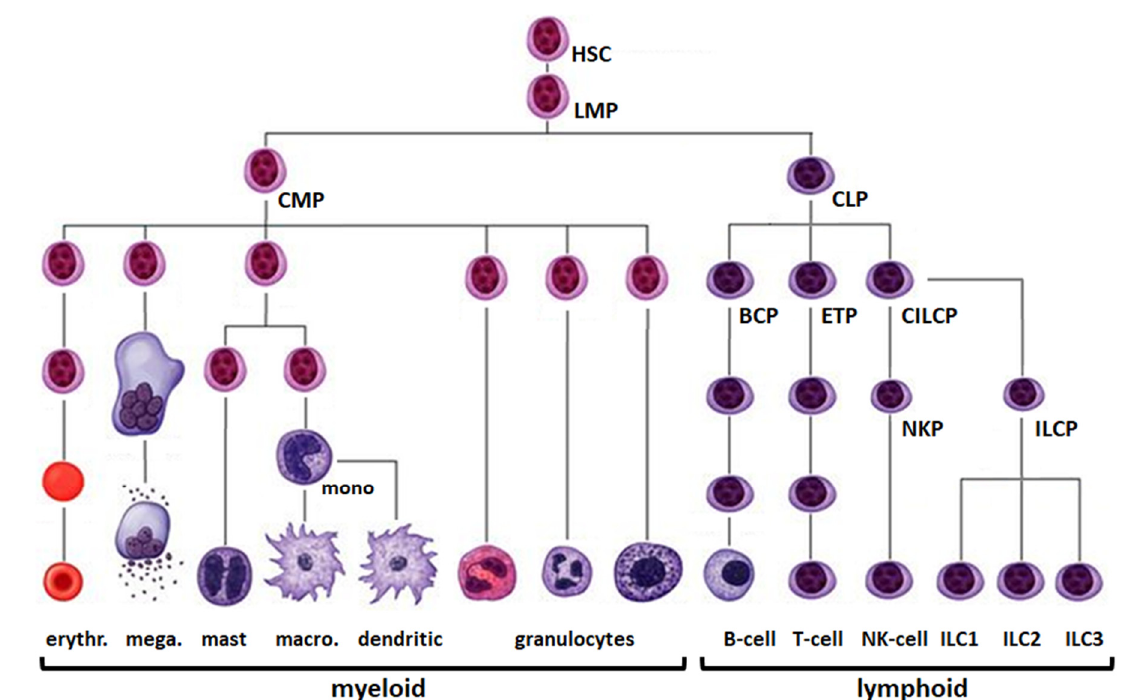
Figure 1. Schematic presentation of hematopoiesis. This diagram depicts the progenitors and terminally differentiated cells of hematopoiesis, comprising the myeloid ( left ) and lymphoid ( right ) lineage. The following abbreviations are used: BCP: B-cell progenitor, CILCP: common ILC progenitor, CLP: common lymphoid progenitor, CMP: common myeloid progenitor, ETP: early T-cell progenitor, HSC: hematopoietic stem cell, ILC(P): innate lymphoid cell (progenitor), LMP: lymphoid and myeloid primed progenitor, NKP: NK-cell progenitor. Figure modified from www.pinterest.de.